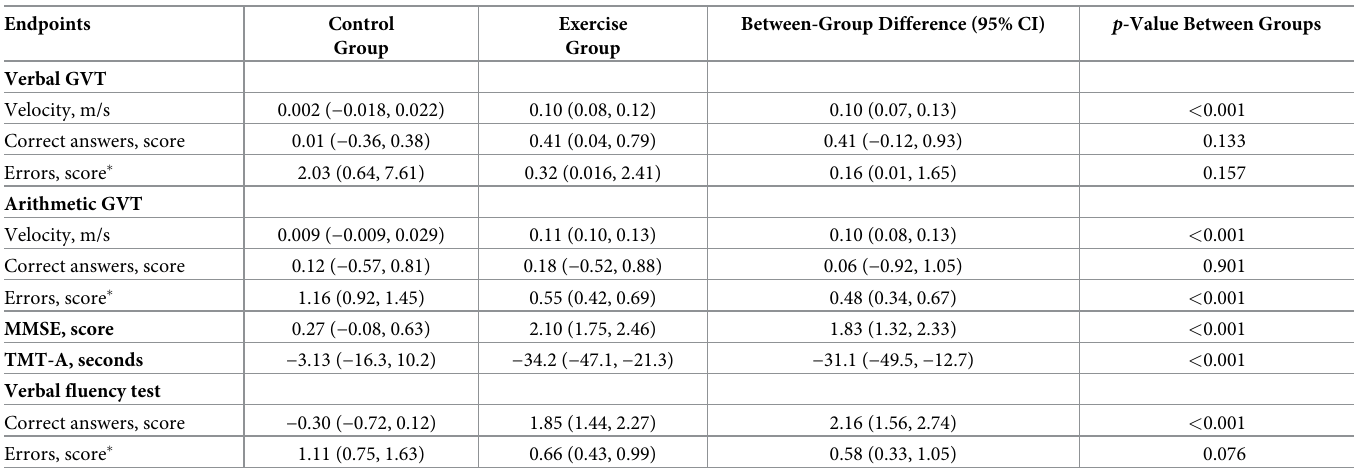
Table 2. Results of study endpoints by group.